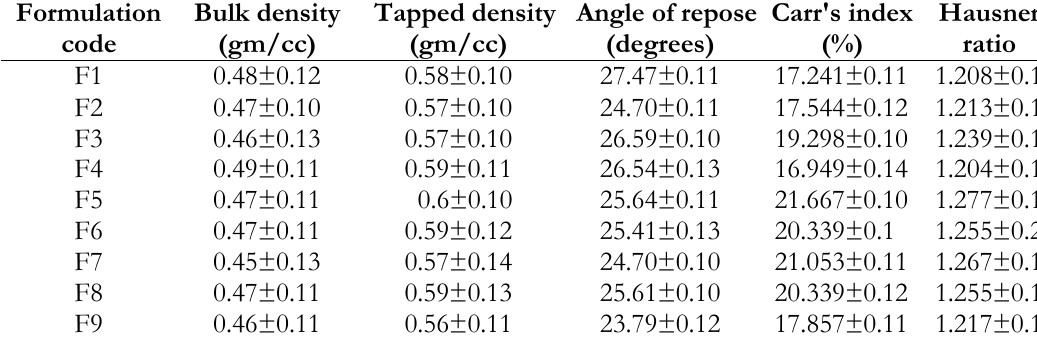
TableV. Evaluation of pre-compression parameters of fast dissolving tablets Formulation